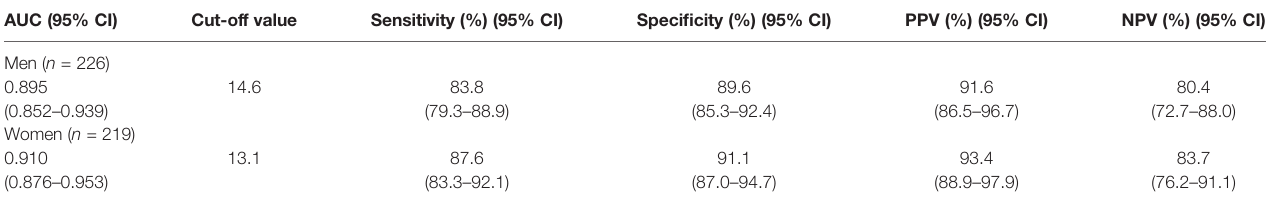
TABLE 5 | Receiver operating characteristic curve analysis of PrFT in identifying MetS in newly diagnosed T2DM divided by sex. AUC (95% CI) Cut-off value Sensitivity (%) (95%